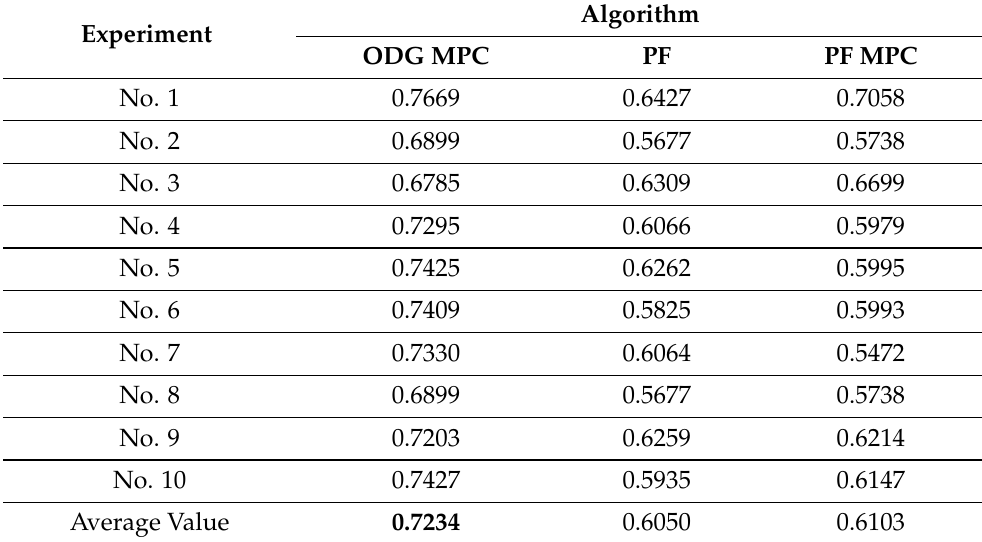
Table 5. Results of the safety metric ( ST